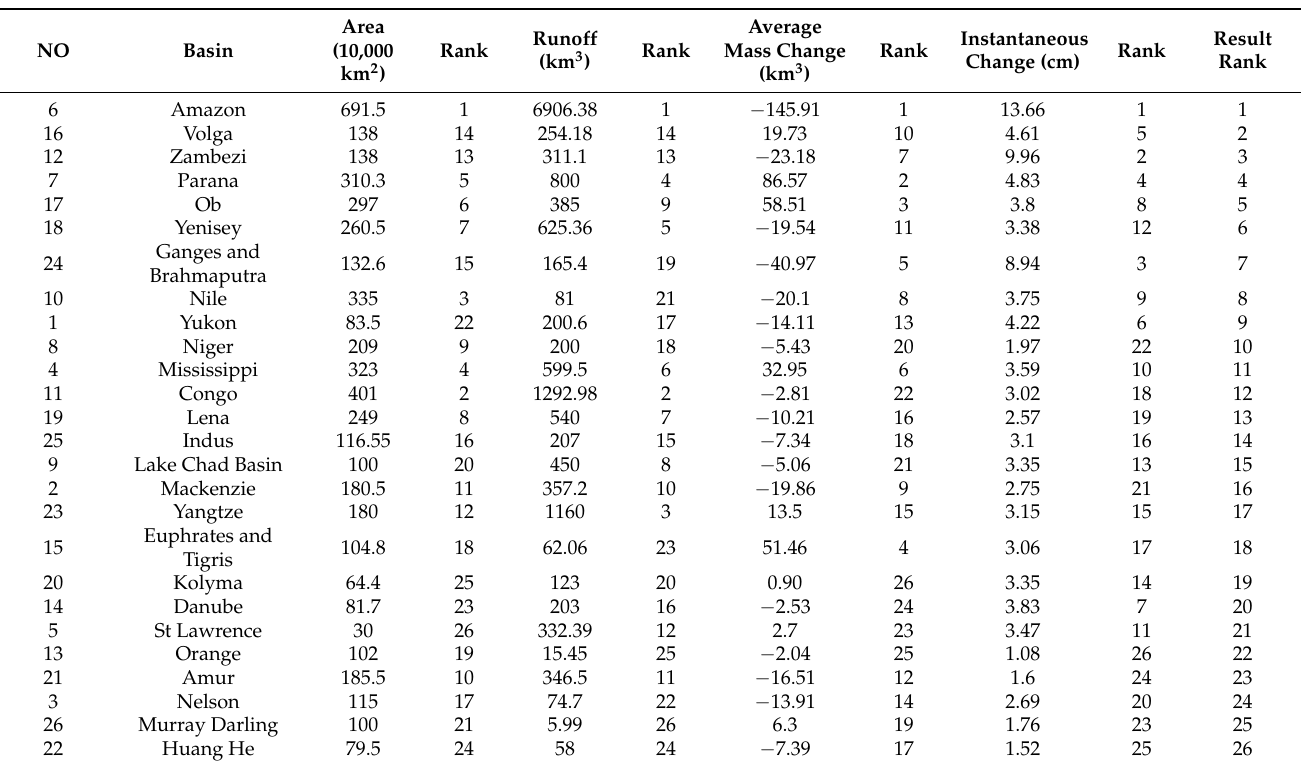
ranking of overall quality change in each watershed, and the size and ranking of the instantaneous change in water storage in each watershed. Table 19. Statistical table of watershed area, annual runoff, annual change, instantaneous change information and ranking for 26